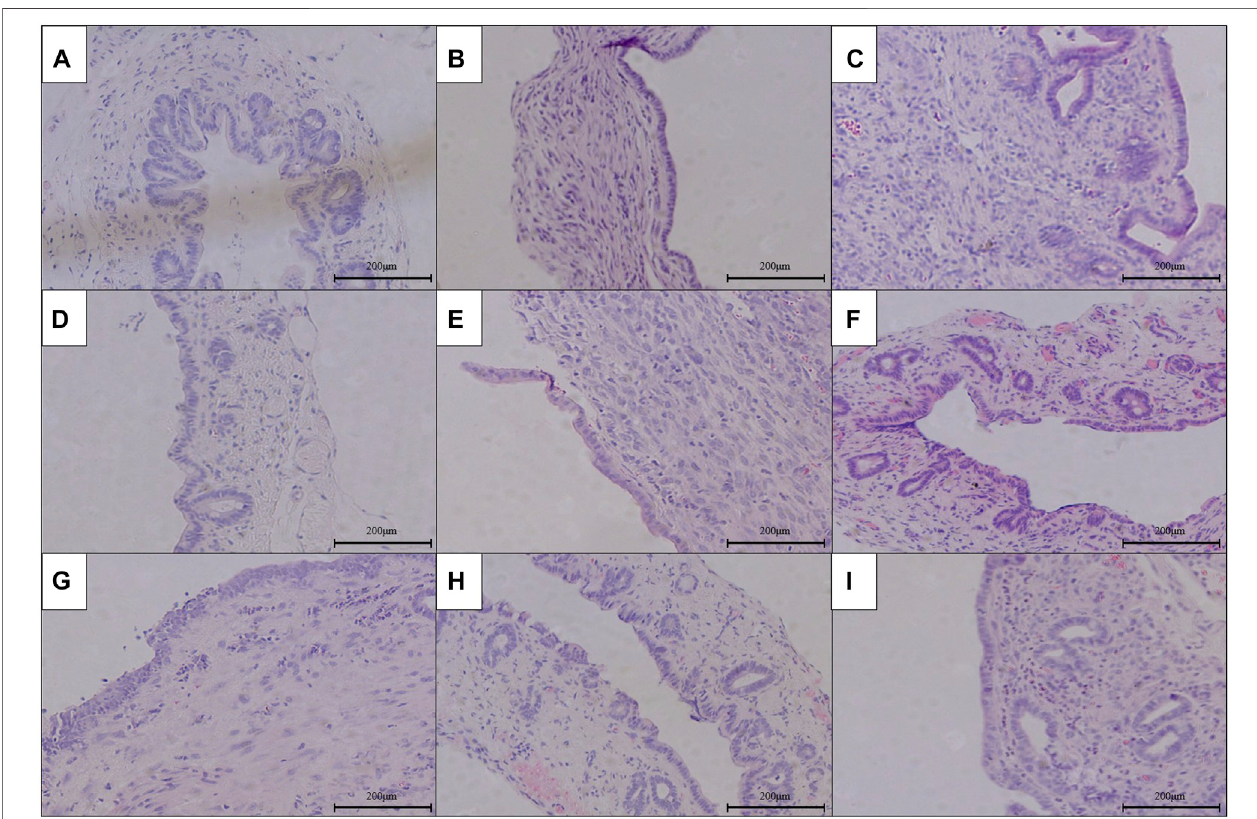
FIGURE4| HEstainingofanastomoticstomaindifferentgroupsaftertheRCJSprocedure( × 200). (A) Shamoperationgroup. (B) Controlgroupat1 weekafterthe RCJS procedure. (C) Control group at 1 month after the RCJS procedure. (D) Anisodamine intervention group at 1 week after the RCJS procedure. (E) Anisodamine interventiongroupat 1 month after theRCJSprocedure. (F) Neostigmineinterventiongroupat1 weekafter theRCJSprocedure. (G) Neostigmine intervention groupat 1 month after the RCJS procedure. (H) Combination group at 1 week after the RCJS procedure. (I) Combination group at 1 month after the RCJS procedure.